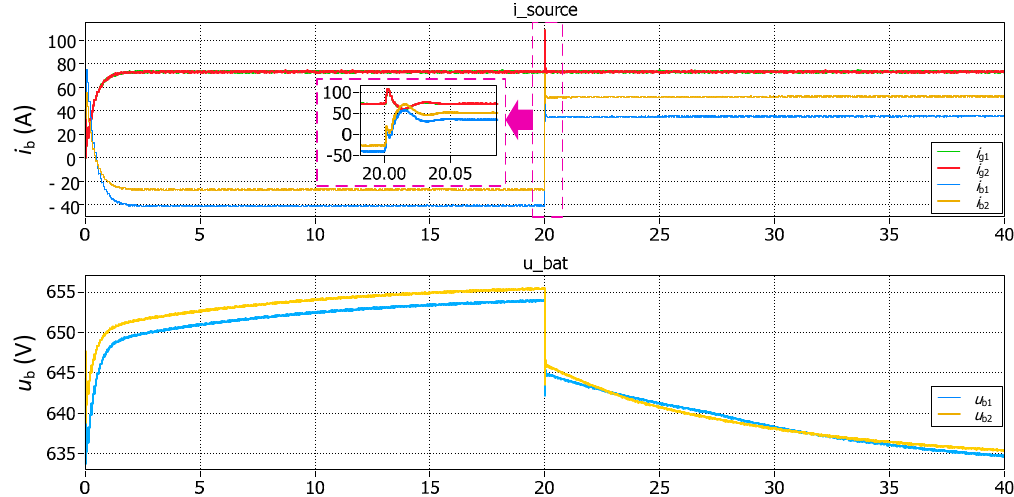
Figure 13. The rectifier, battery current, and battery voltage in hybrid mode.